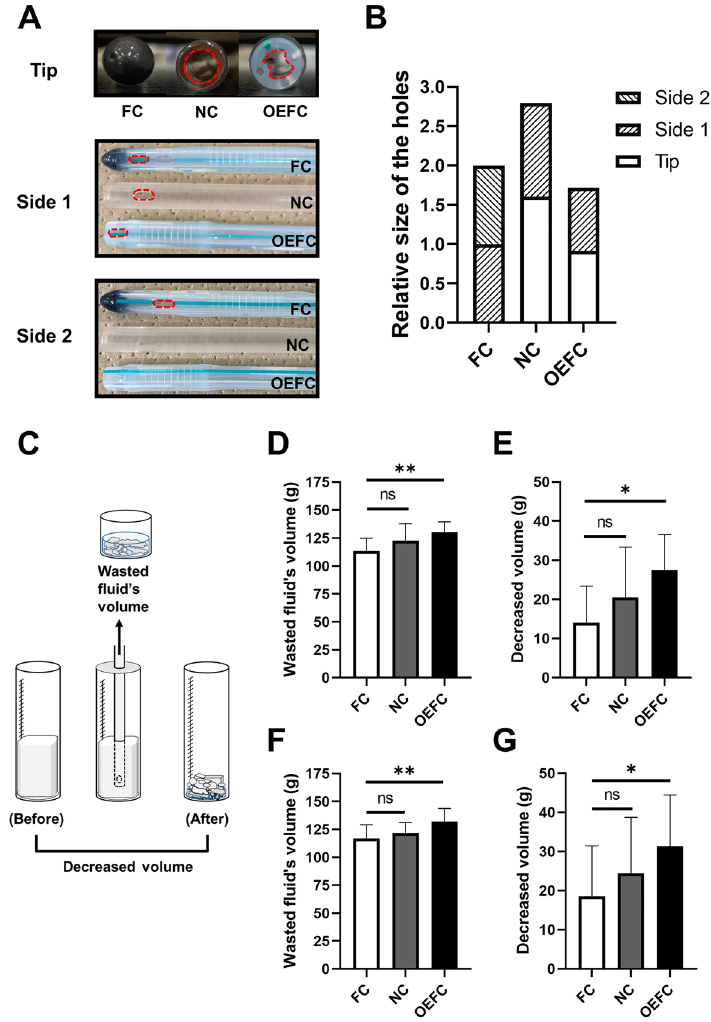
Figure 1. The efficiency of MBW. ( A ) Photographs viewed from the tip or each side of the catheters used in this study. Red dotted line shows the outline of each hole. ( B ) Total relative area of the holes in each catheter. The area of one of the holes in FC was set to 1. ( C ) The schematic image of how to evaluate MBW. ( D , E ) Wasted fluid’s volume and decreased clot’s volume of soft tofu. ( F , G ) Wasted fluid’s volume and decreased clot’s volume of hard tofu. The decreased volume of PBC after the procedure mimicking MBW was done by 11